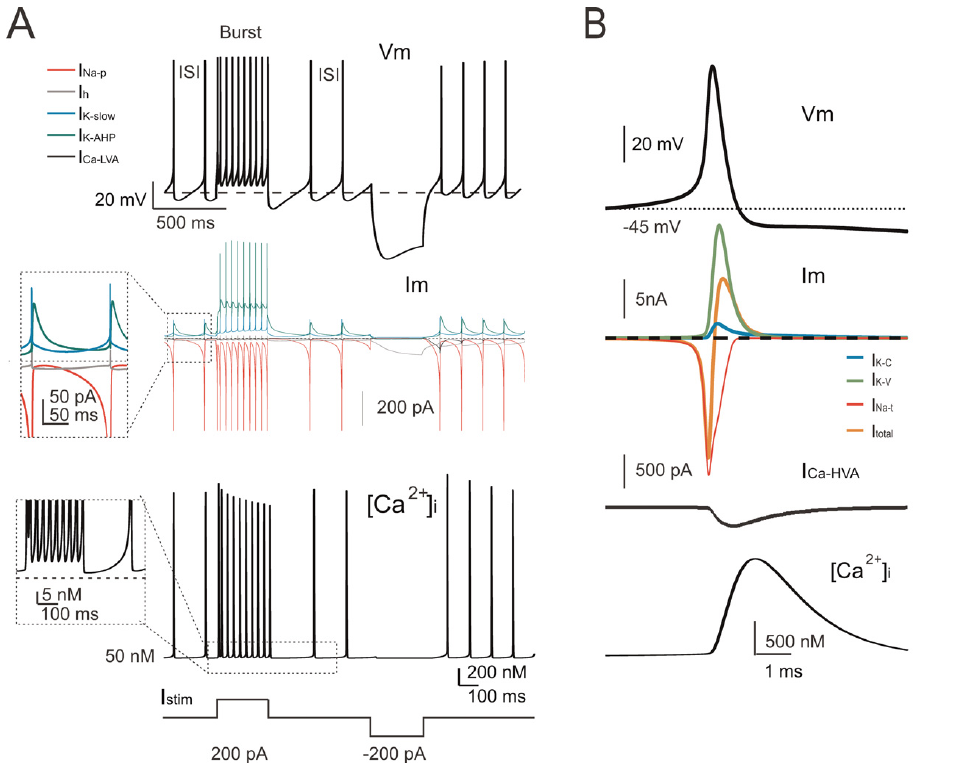
Figure 6. Ionic currents and intracellular calcium changes . ( A ) The traces show the model response during alternated phases of pacemaking, depolarization, and hyperpolarization (the injected current is shown at the bottom). The voltage trace (Vm) shows the membrane potential change. The current traces (Im) show the ionic currents in the ISI. It should be noted that I Na-p , I K-AHP , and I Kslow , but not I h , show a marked voltage-dependent modulation during the pacemaker cycle. The calcium ([Ca 2 þ ] i ) trace shows that [Ca 2 þ ] i is promptly reset to its background level of 50nM following a transient increase during the spike. The inset shows the [Ca 2 þ ] i accumulation in coincidence with the high-frequency bursts and spike frequency adaptation. ( B ) The traces enlarge the model response during a single action potential (Vm). The ionic currents primarily responsible for action potential generation (Im) and the Ca 2 þ currents (I Ca-HVA ) are shown along with the [Ca 2 þ ] i transient. Note the delayed activation of the repolarizing mechanisms and of the slow time course of [Ca 2 þ ] i transient. I Na-t , I K-C , and I K-V are much larger than currents governing the ISI (cf. panel A) .